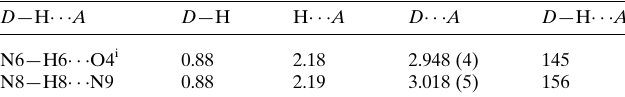
Table 1 Hydrogen-bond geometry (A˚ , (cid:3) ).